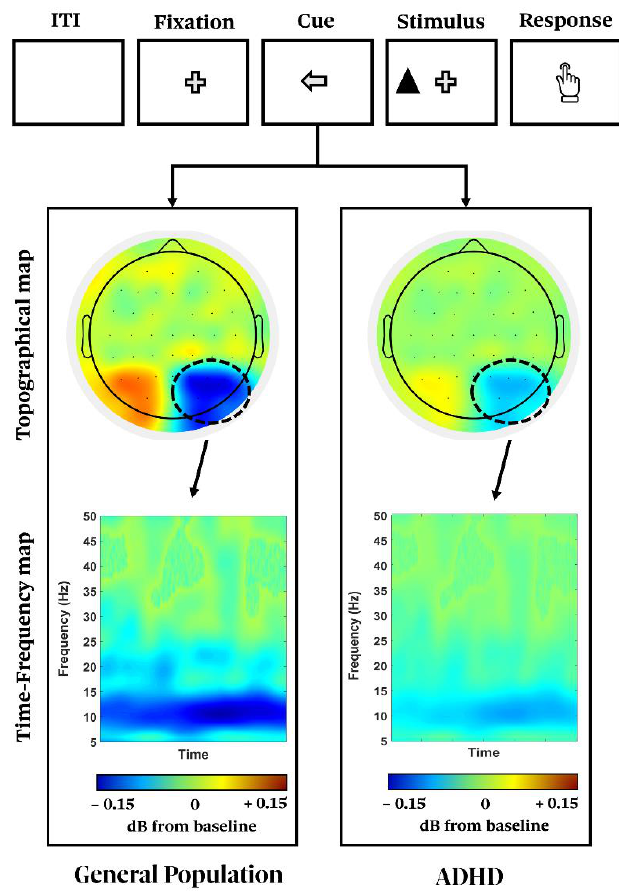
Figure 4. Simulated data showing a demeaned modulation in the inhibitory alpha power in ADHD (relative to controls) during the anticipation of a target stimulus in a visual task. Noteworthily, the lack of modulation comprises both contralateral ERD and ipsilateral ERS.